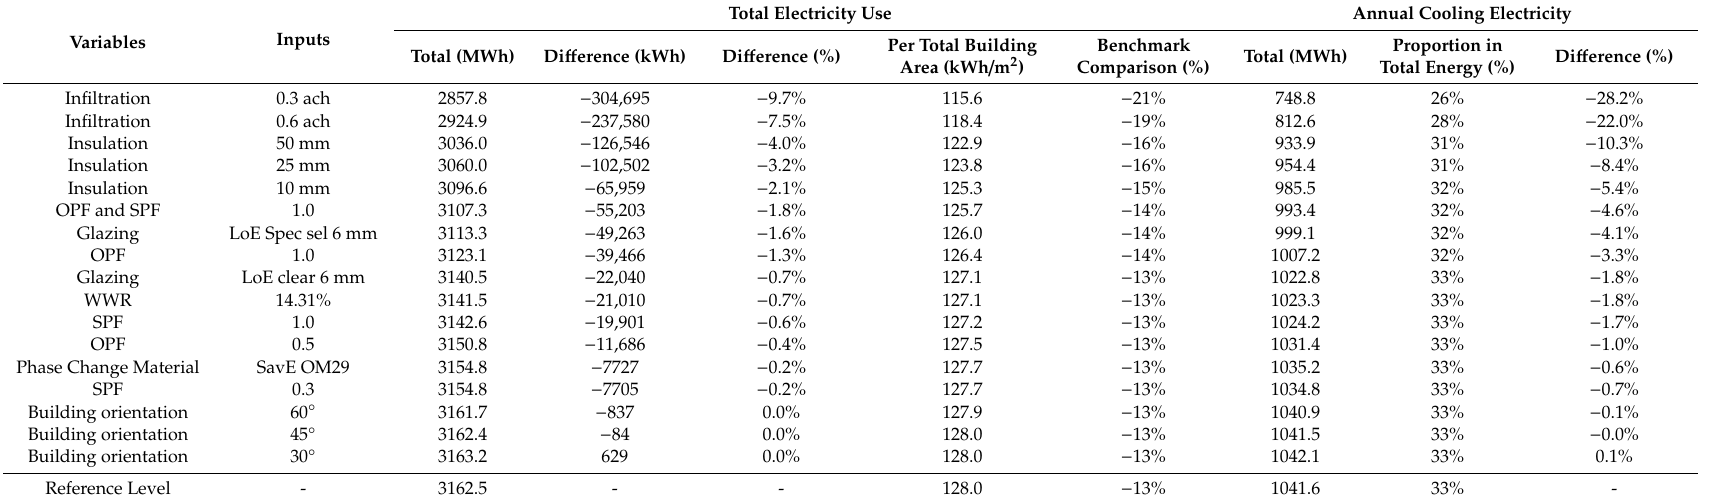
Table 5. Annual electricity consumption